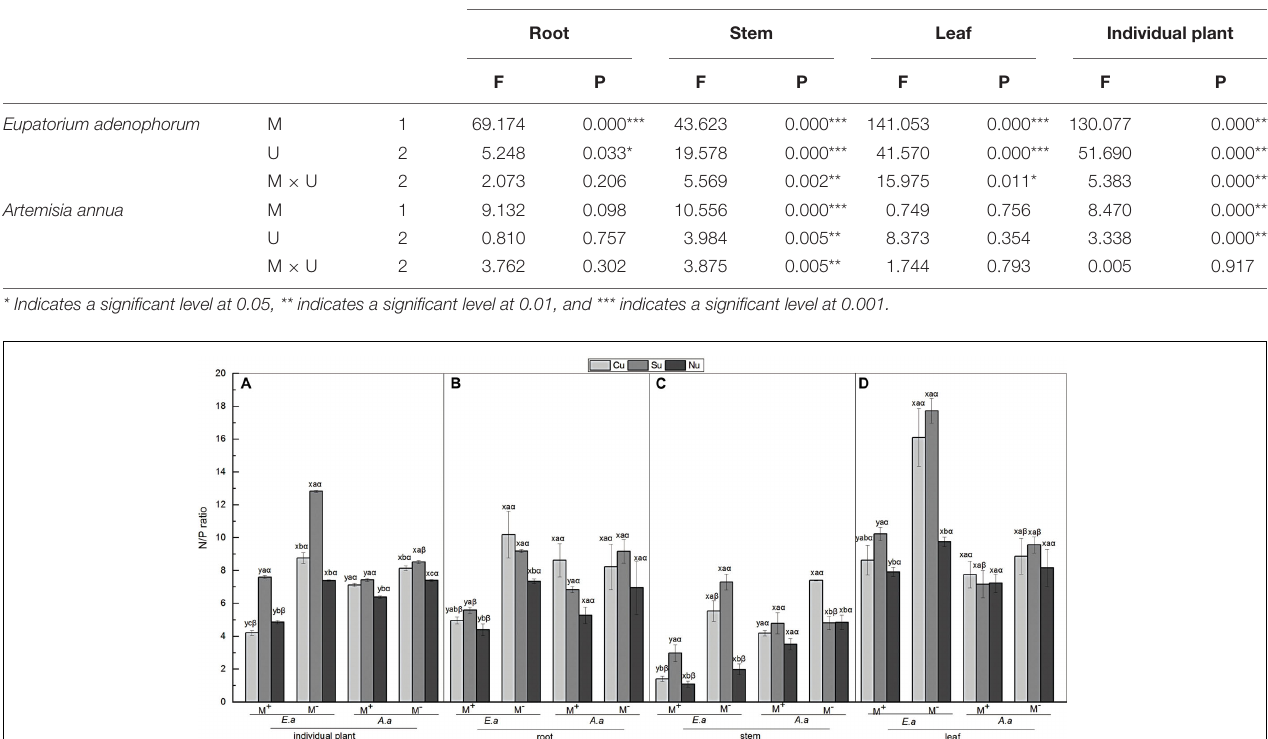
TABLE 5 | Two-Way ANOVAs for the effects of mycorrhizal fungus (M + vs M − ) and nutrient utilization treatments (Cu vs Su vs Nu) on N/P ratio of the invasive plant Eupatorium adenophorum and the native plant Artemisia annua . Plant species Factors df N/P ratio Root Stem Leaf Individual plant F P F P F P F P